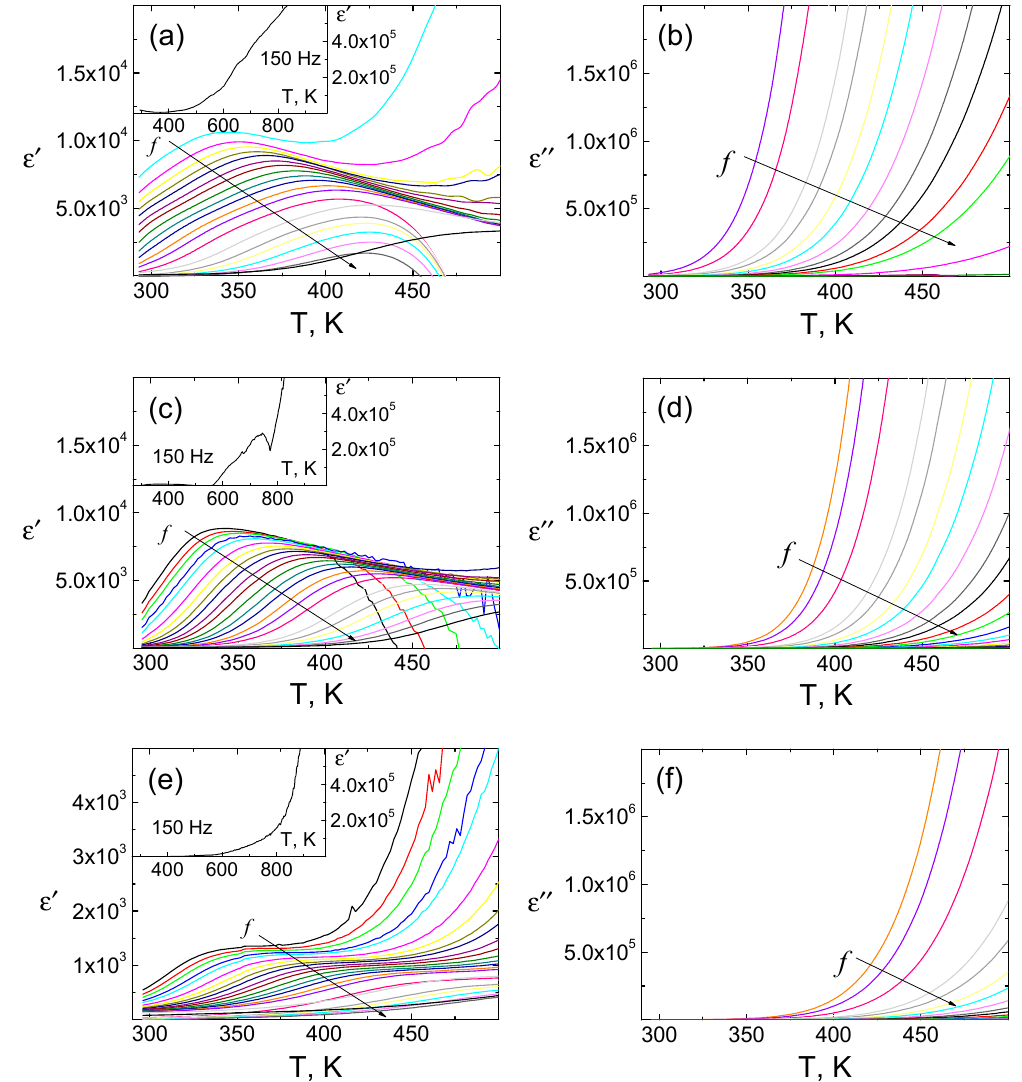
Figure 3. The dependencies of ε ’/ ε 0 and ε ’’/ ε 0 of Bi 1 − x Er x FeO 3 ceramic samples on the temperature in the frequency range 25–2 × 10 6 Hz. (Arrows show the increase in the frequency, f ; ( a , b ) BiFeO 3 ; ( c , d ) Er— x = 0.10, ( e , f ) x = 0.20.